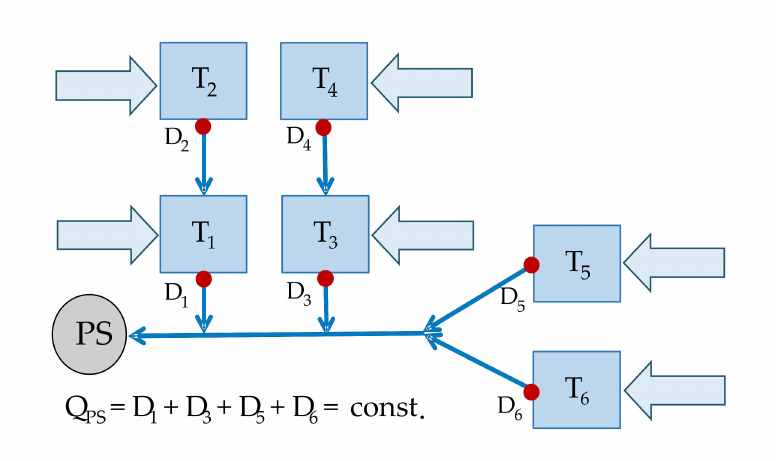
Figure 3. Case study catchment for measured data-based sewer system optimization; T = combined sewer overflow tank, D = controlled outflow, PS = pumping